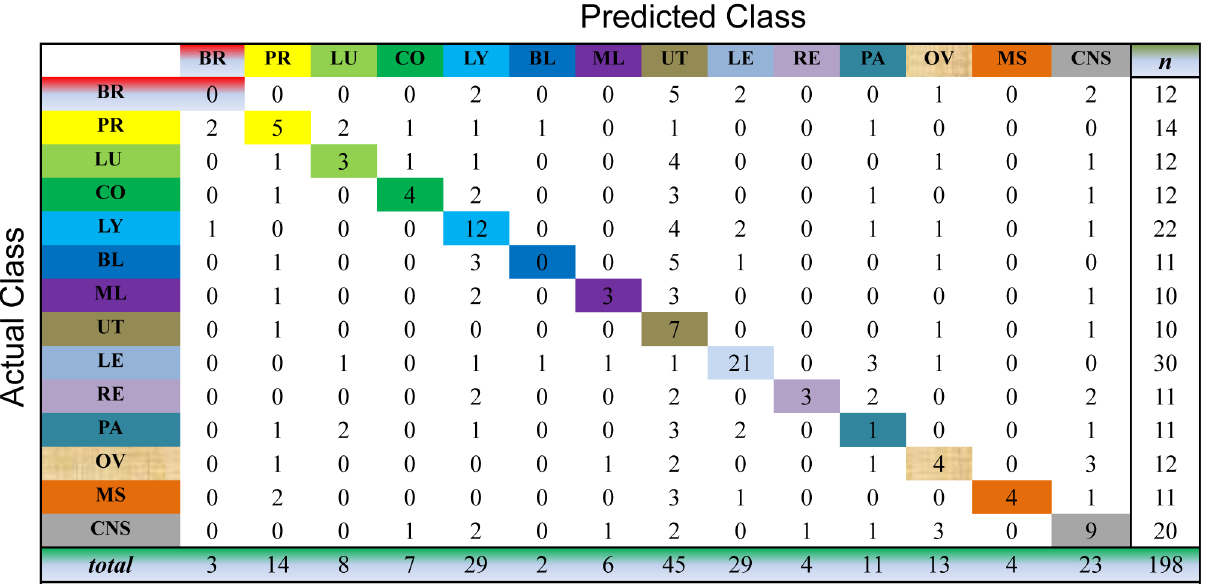
Fig 5. Confusion matrix of prediction results using CNMF, which achieves a total accuracy of 38.4%. Matrix delineates distribution of actual compared with predicted class membership for multiclass cancer prediction on the GCM dataset.